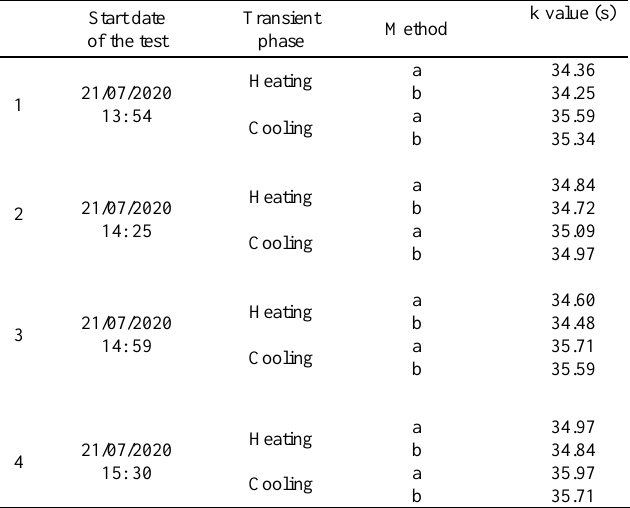
TABLE IV: R EPEATABILITY